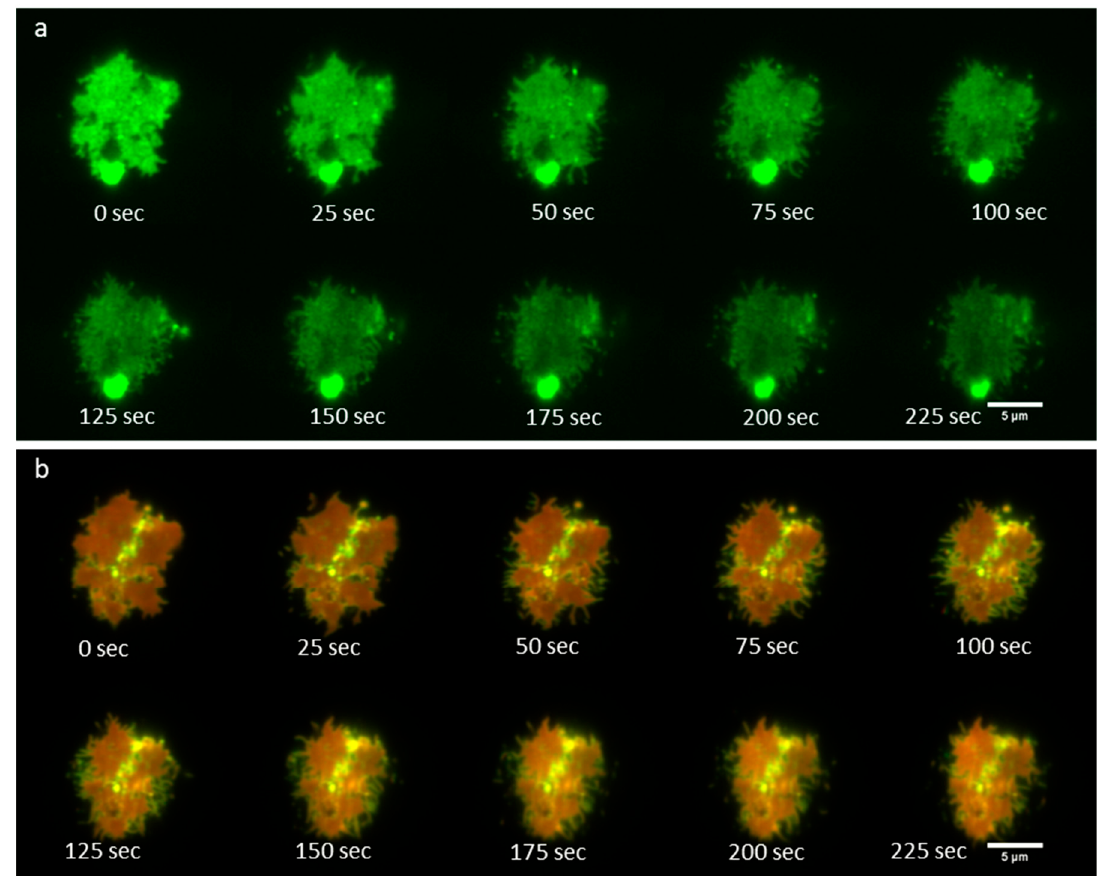
Figure 6. Time-lapse imaging of IgE receptor patch dynamics together with P-TIRF imaging of membrane curvature. ( a ) IgE-488 bound Fc ε RI; ( b ) P-S two-color overlay image. Images were acquired with the Zyla 4.2 + sCMOS